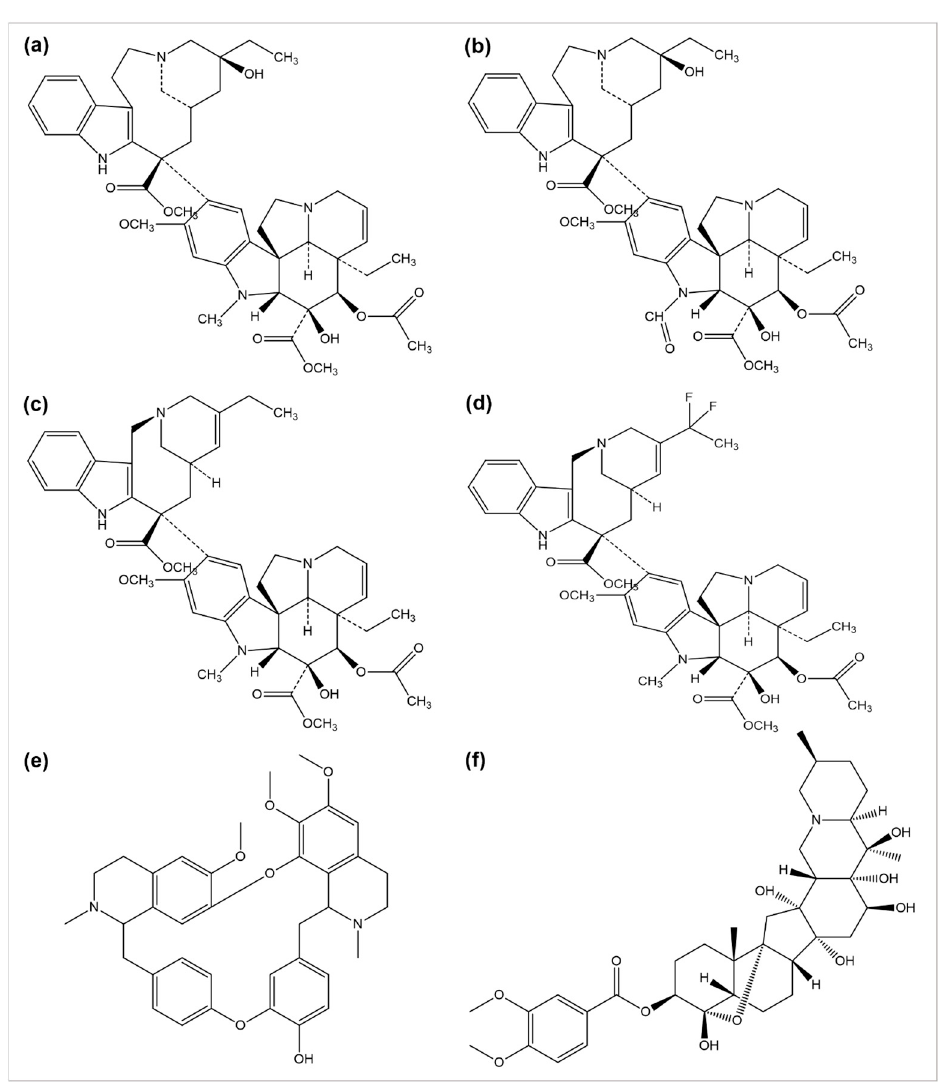
Figure 2. Chemical structures of ( a ) vinblastine, ( b ) vincristine, ( c ) vinorelbine, ( d ) vinflunine, ( e ) berbamine, and ( f ) veratridine.